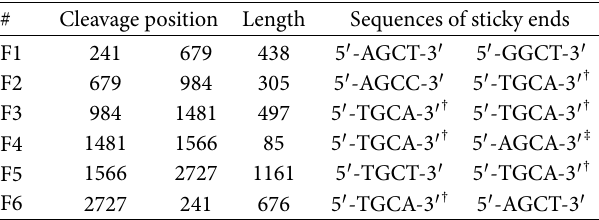
Table 1: DNA fragments of plasmid pUC118 DNA cleaved with Bsp1286I.